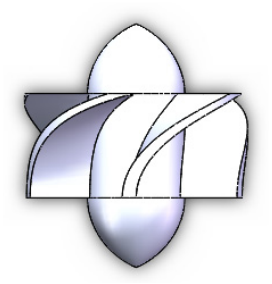
Figure 2. Arc type guide vane.